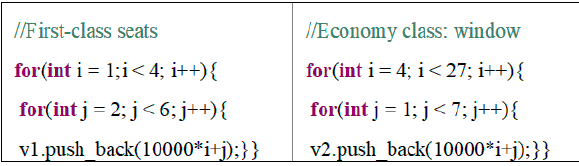
Figure 10. Random strategy seat number generation.